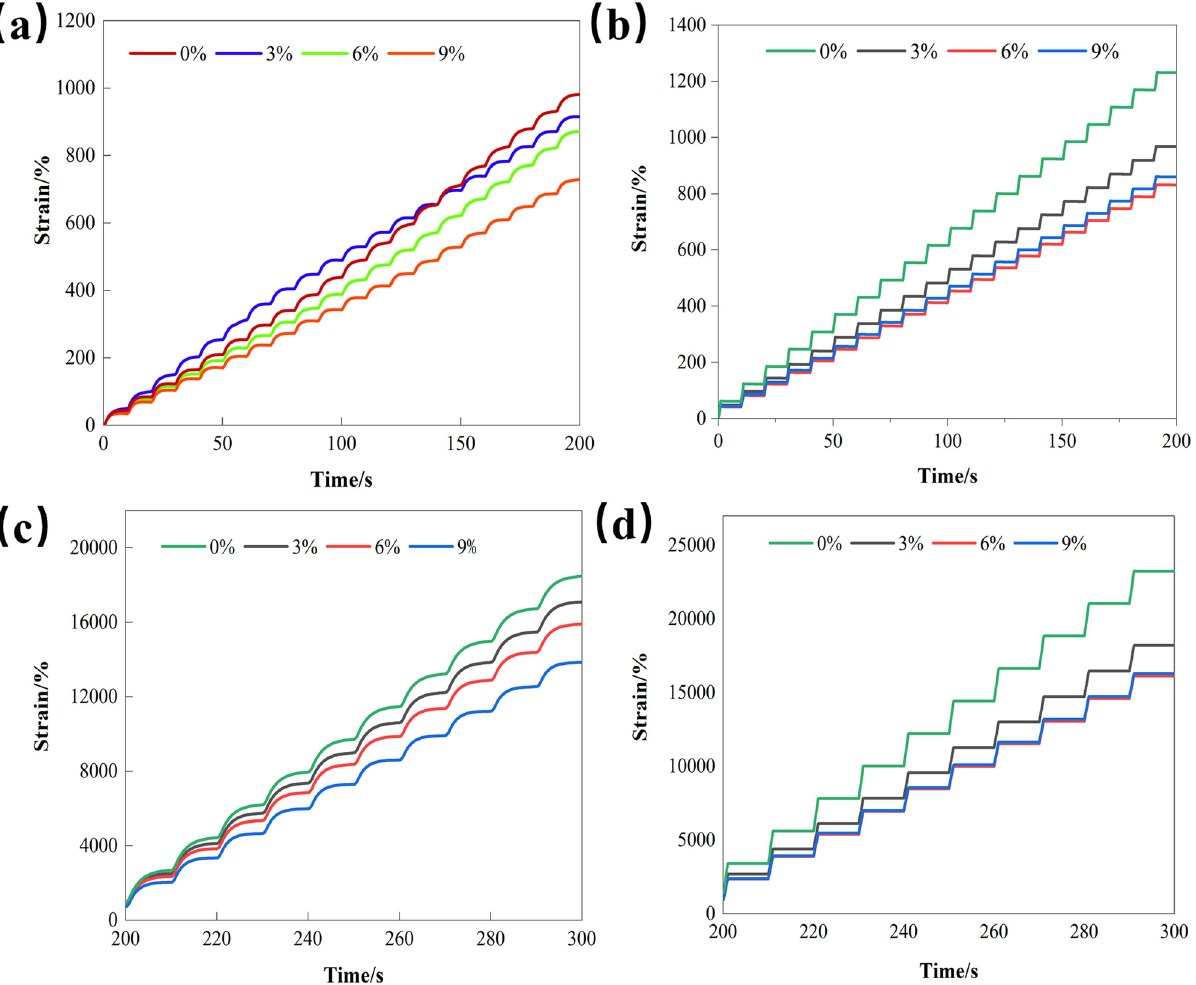
Figure 4: MSCR results of PUA - modi fi ed asphalt under di ff erent parallel plates: ( a ) 8 mm parallel plates/0 – 200 s, ( b ) 25 mm parallel plates/ 0 – 200 s, ( c ) 8 mm parallel plates/200 – 300 s, and ( d ) 25 mm parallel plates/200 – 300